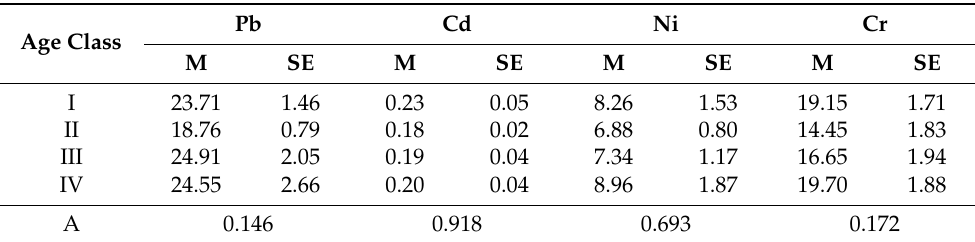
Table 7. Mean (M) with standard error (SE) stocks (kg/ha) of heavy metals in the top (0–30 cm) soil layer under silver birch regeneration by age class.